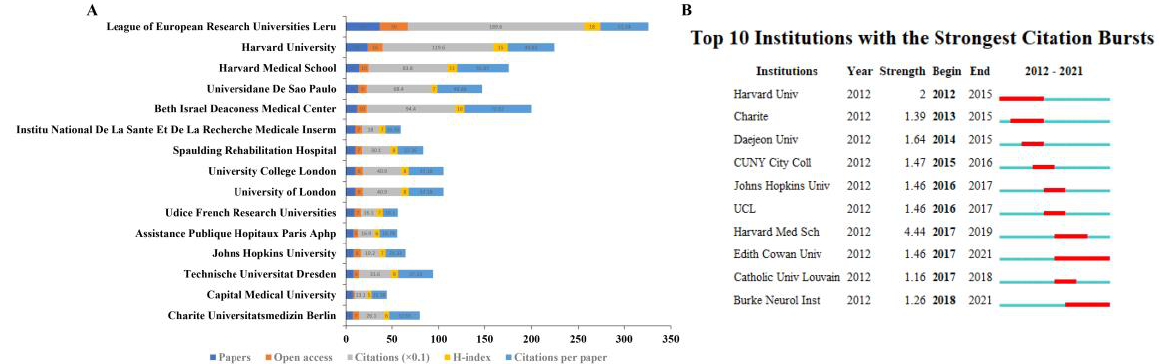
Figure 7. Distribution of global institutions. ( A ) The number of papers, open access papers, citations, H-index, and citations per paper of the top 15 institutions. ( B ) The top 10 institutions according to CiteSpace in terms of citation bursts. The blue bars mean the reference was published; the red bars mean citation